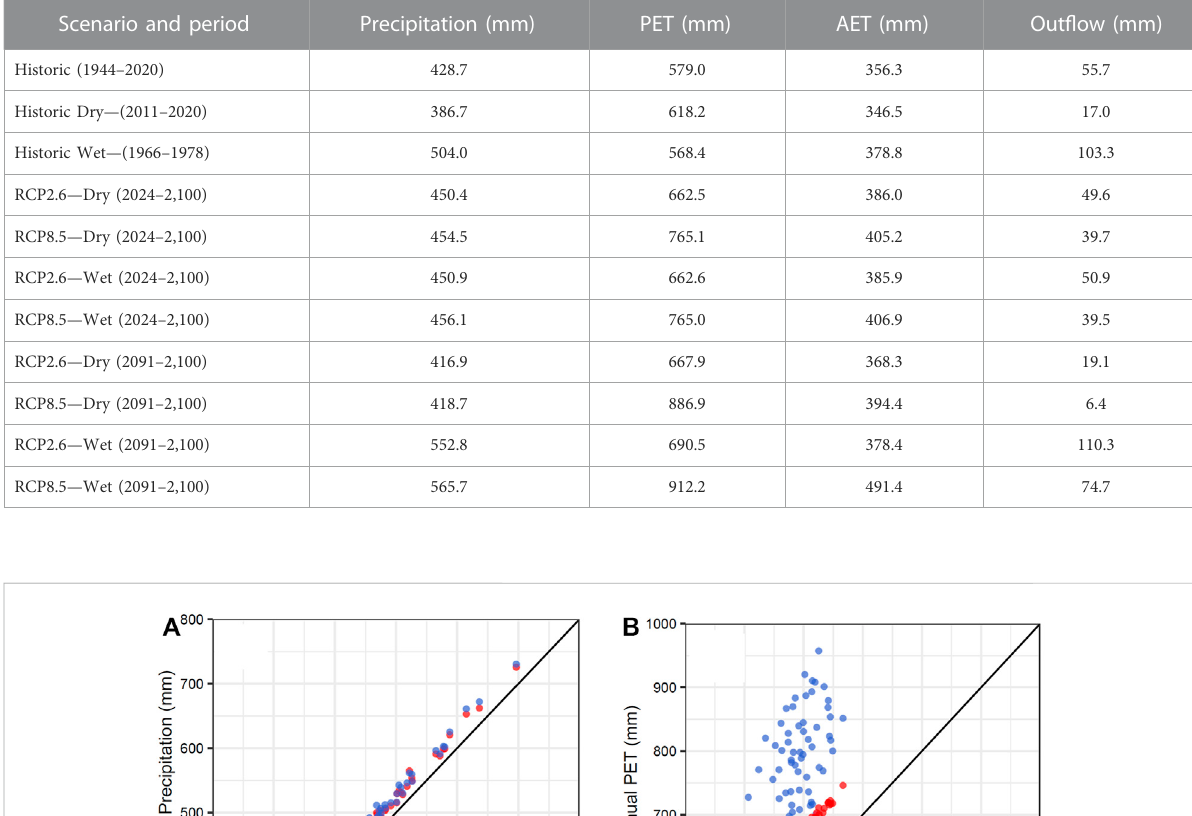
TABLE 3 Annual averages — precipitation and potential evapotranspiration (PET) and modeled out fl ow and actual evapotranspiration (AET). Scenario and period